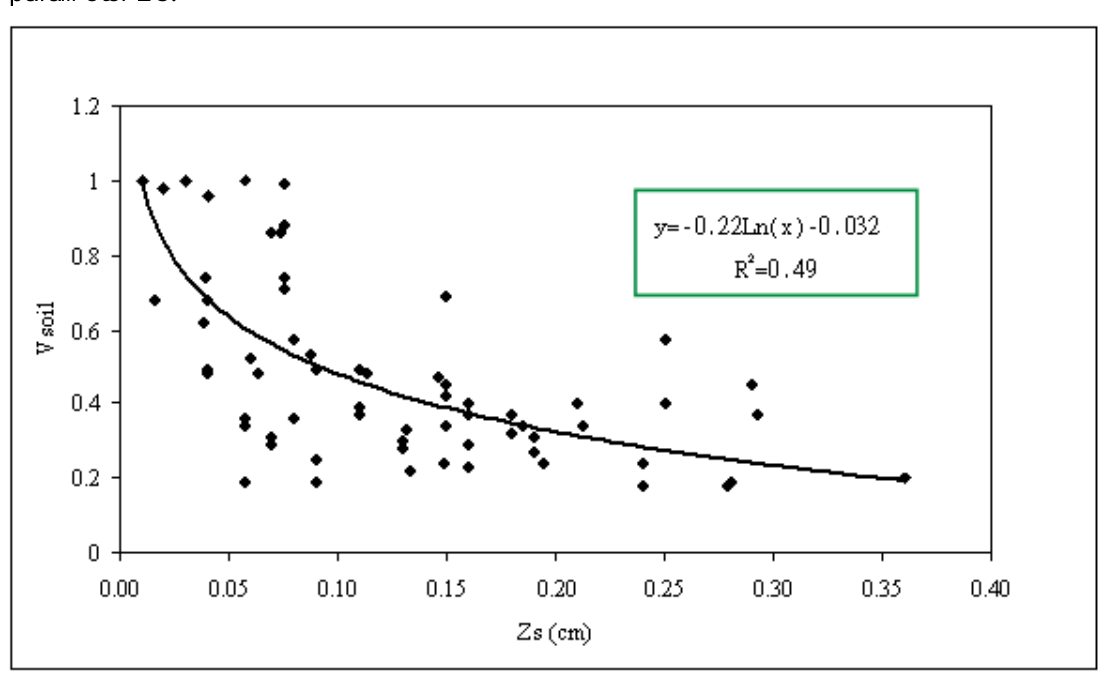
parameter (soil fraction) as a function of the soil roughness soil